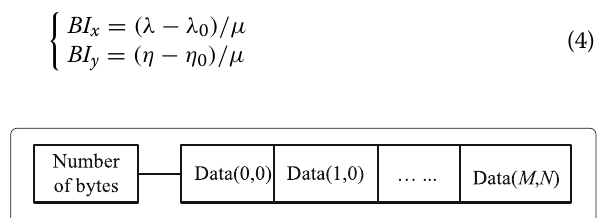
Fig. 6 The coding storage structure of meteorological